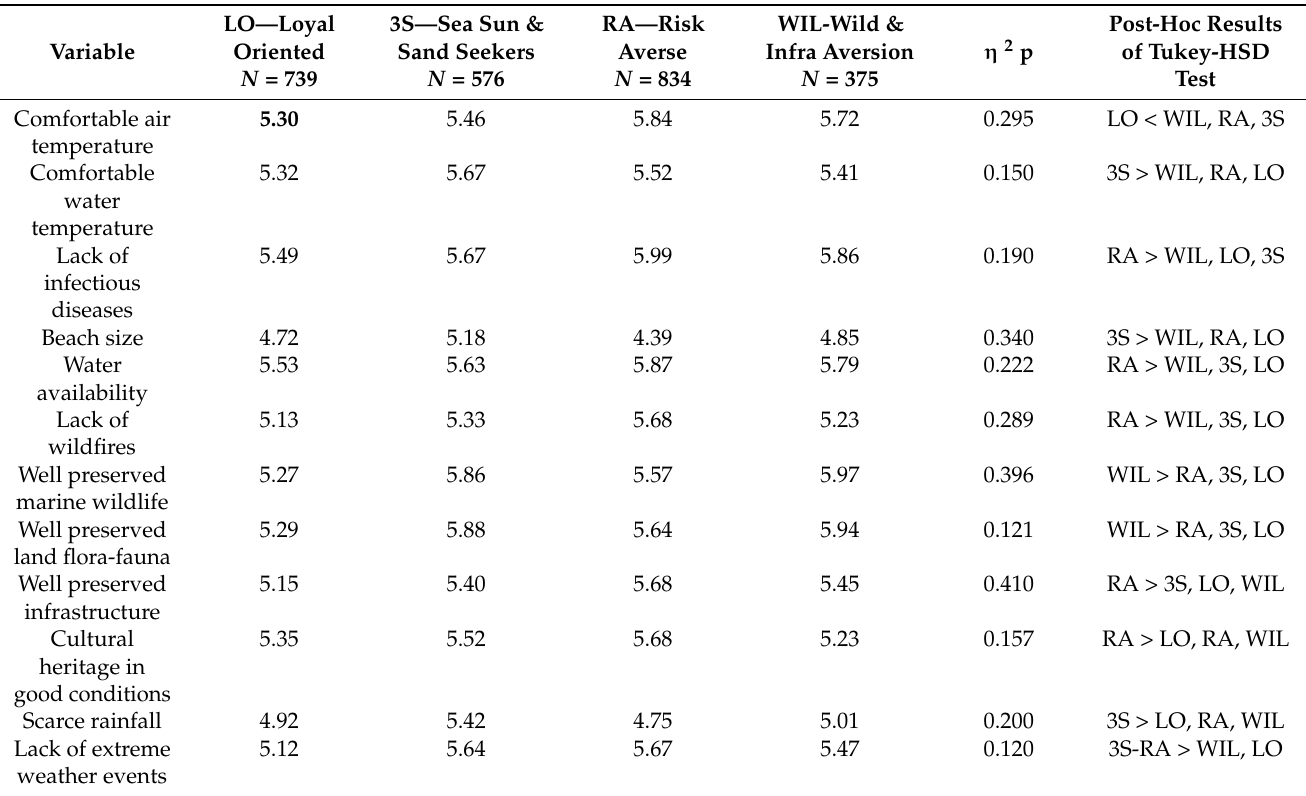
Table 7. Cluster differences based on the importance given to the conservation of environmental attributes to visit an island. Variable